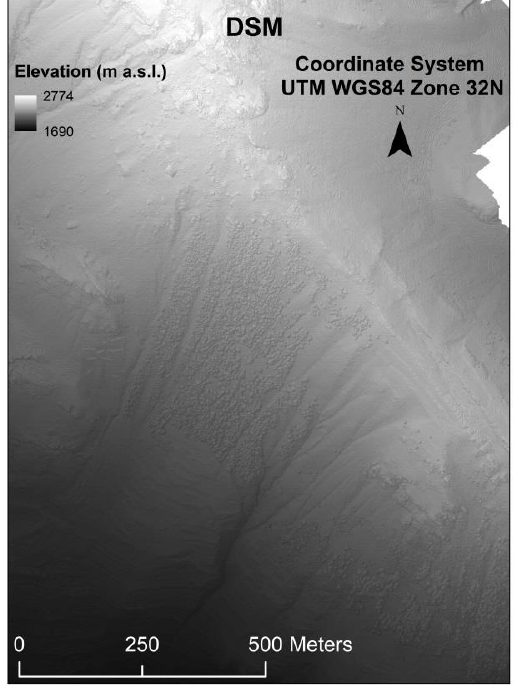
Figure 6. Particular of generated DSM, tree cover is visible on the right mountain